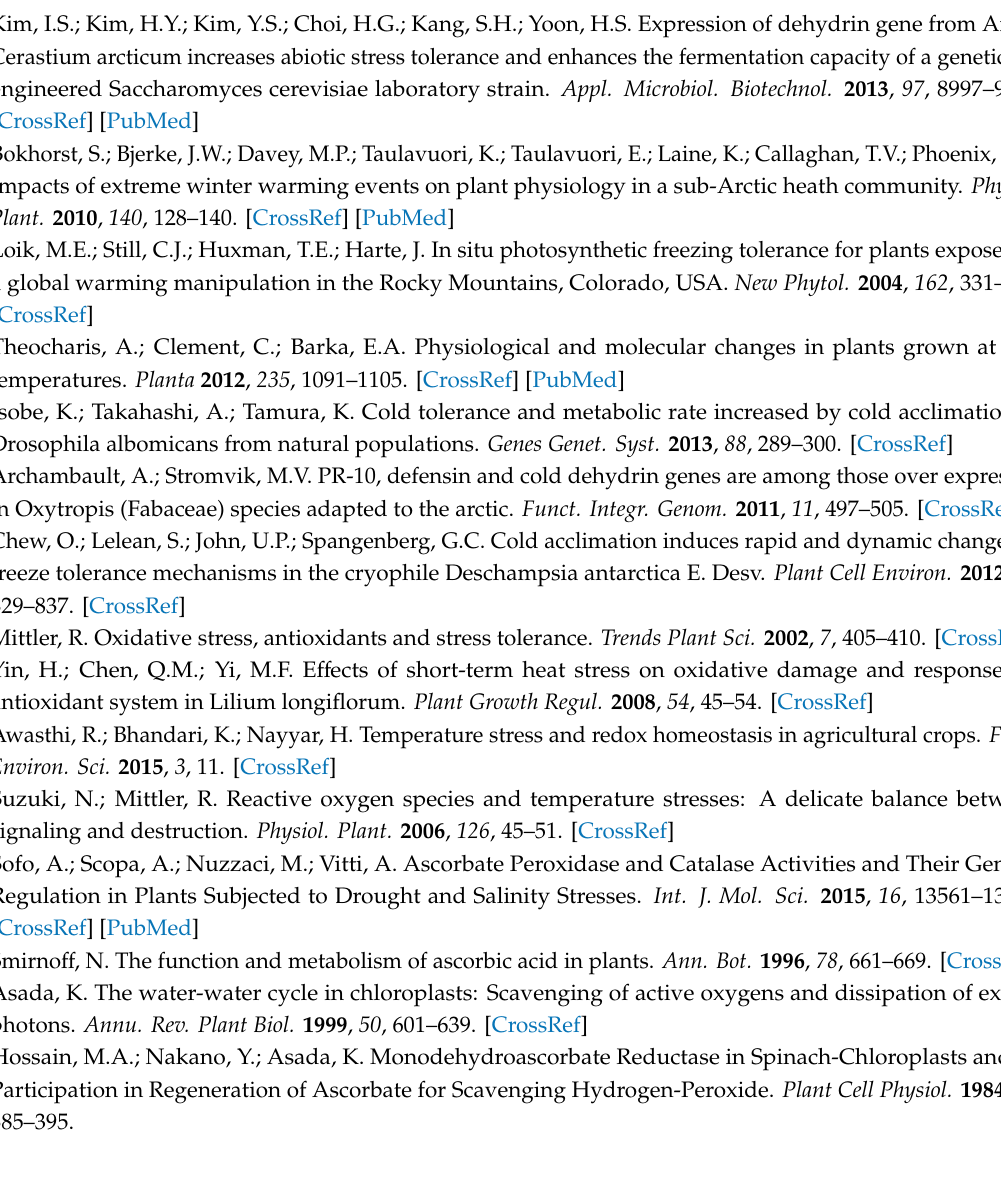
Figure S1: Schematic diagram of expression vector constructs for Saccharomyces cerevisiae and Escherichia coli ., Table S1: Genotype of the strains used in this